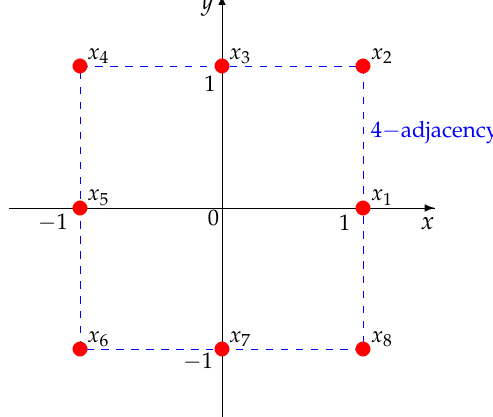
Figure 2. A digital image Y with the 4-adjacency relation along with the 8-dotted